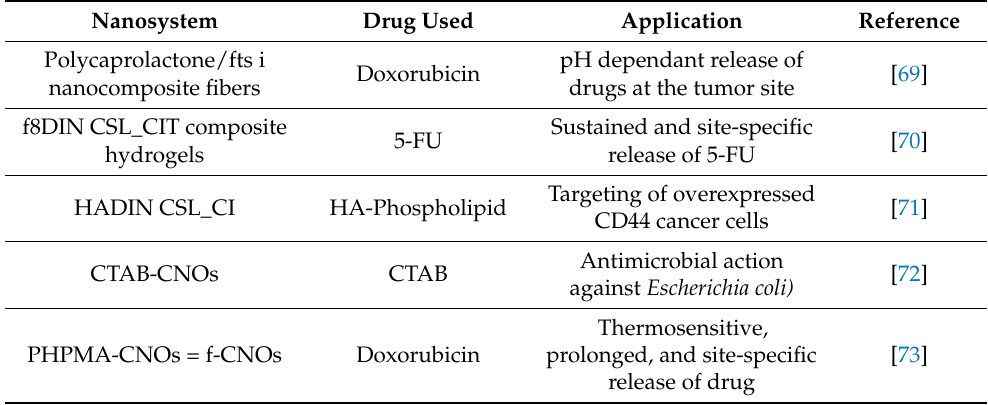
Table 3. Recent developments in CNO-based drug delivery